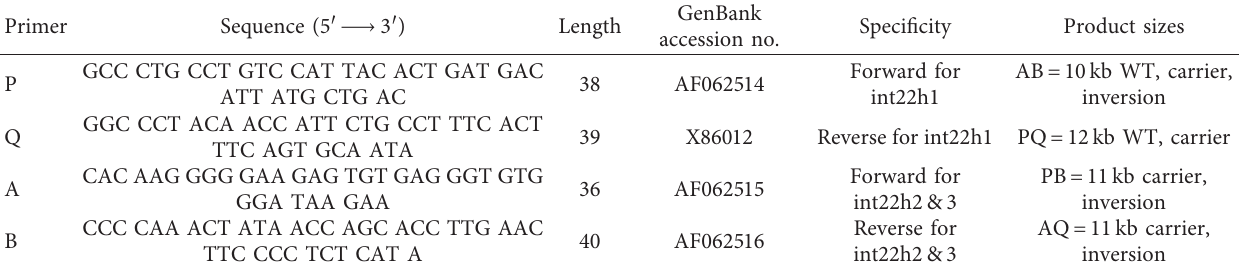
Table 1: PCR primer sequences for amplification of factor VIII